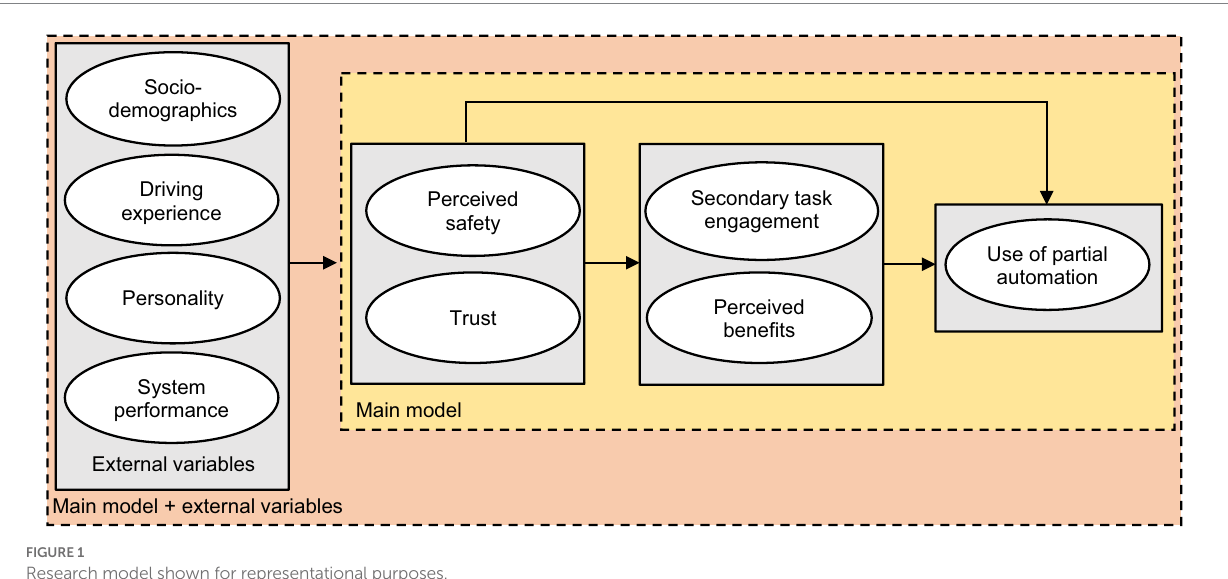
FIGURE 1 Research model shown for representational